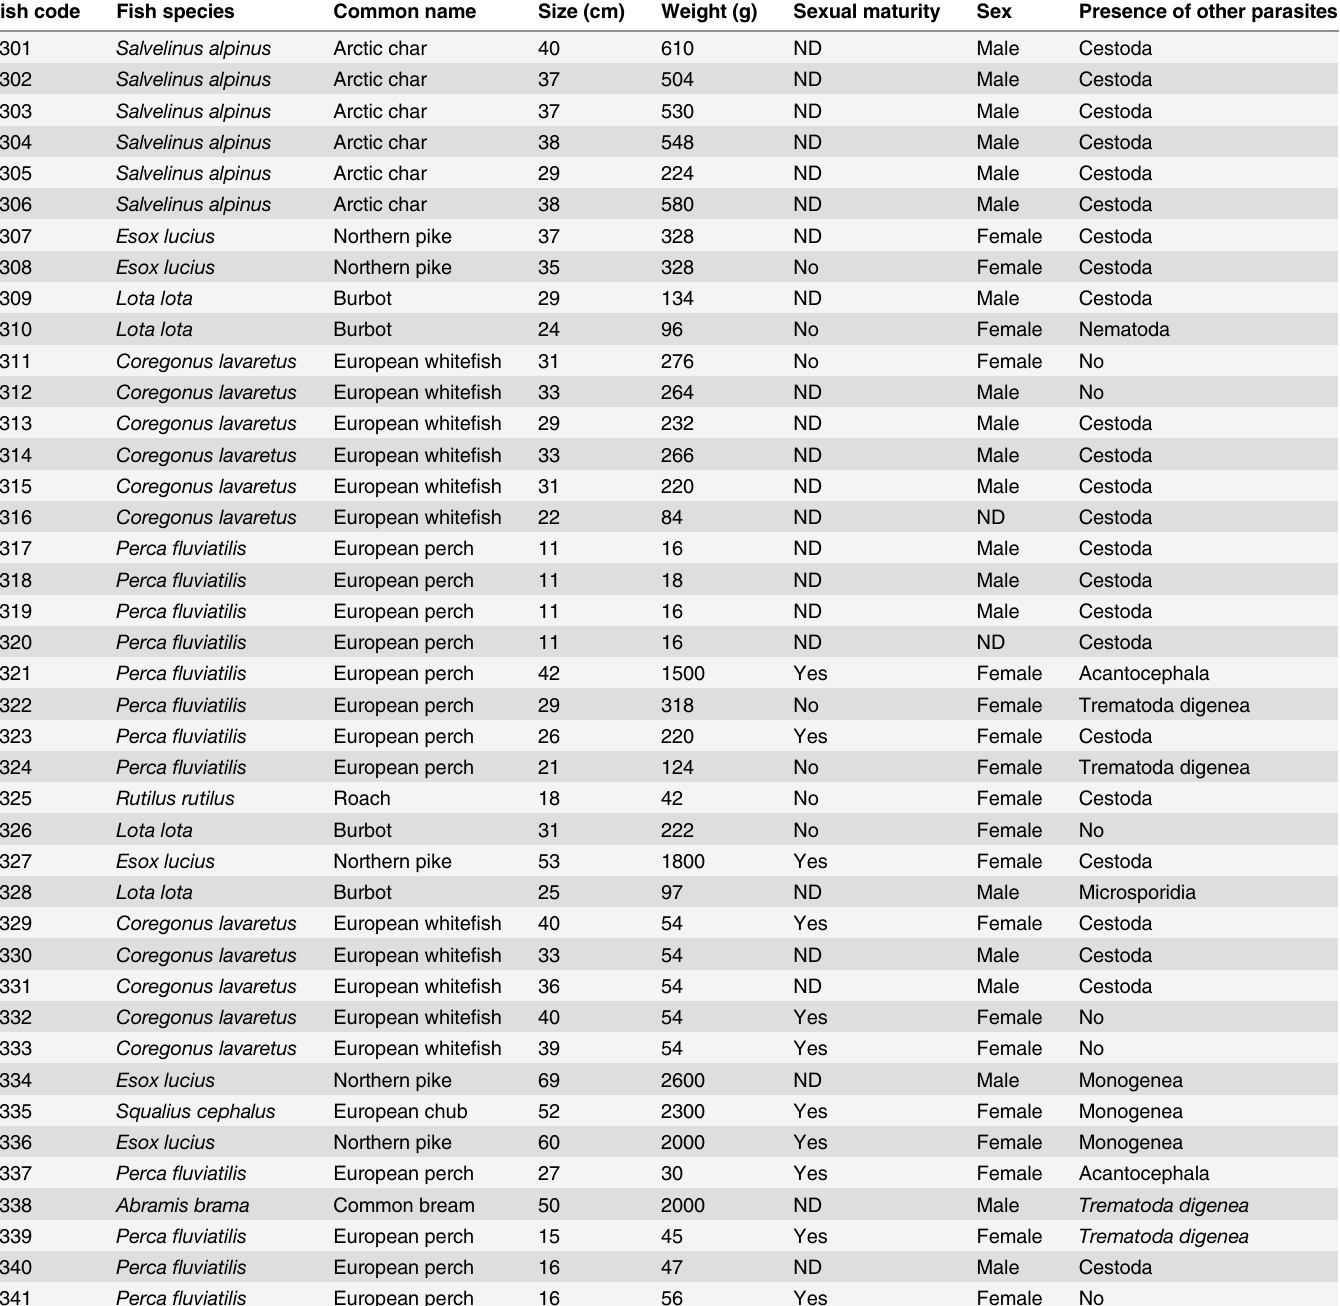
Table 1. Freshwater fish specimens collected in Lake